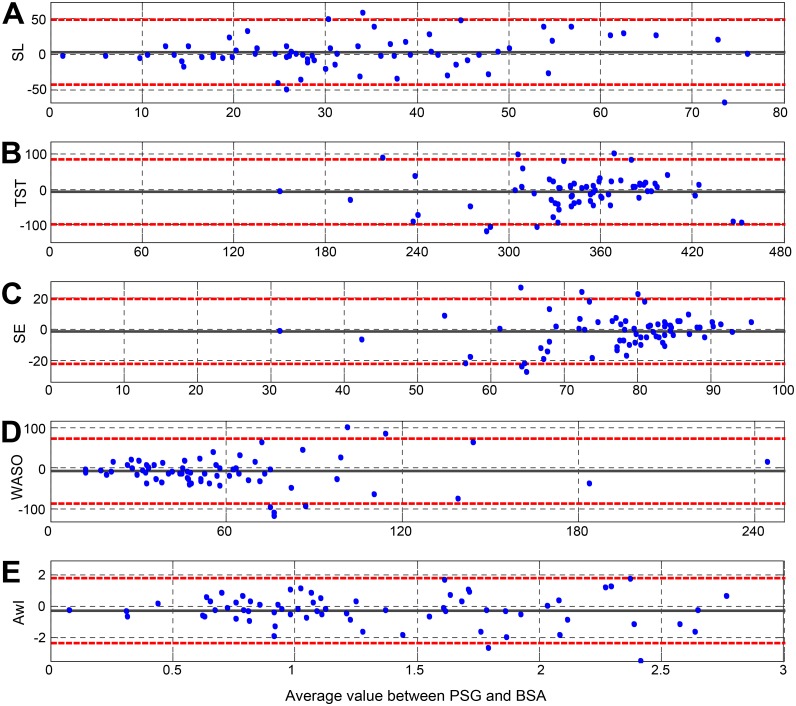
Bland-Altman plot of the PSG & BSA.X-axis represents the mean sleep parameter value between the PSG & BSA (in the relevant parameter units). The Y-axis is the difference between the PSG and BSA sleep quality parameter. The dashed lines represent the 95% CI. (A) SL—Sleep latency, (B) TST—Total sleep time, (C) SE—Sleep efficiency, (D) WASO—Wake time after sleep onset, (E) AwI—the average awakening per hour of time in bed.